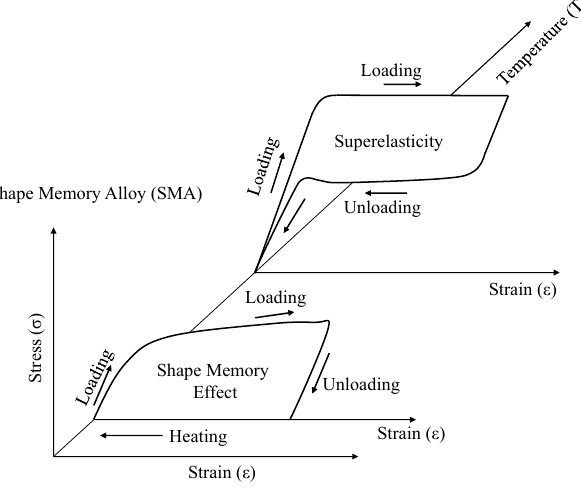
Figure 1. Temperature-dependent stress and strain curves for SMA (shape memory alloy) materials.